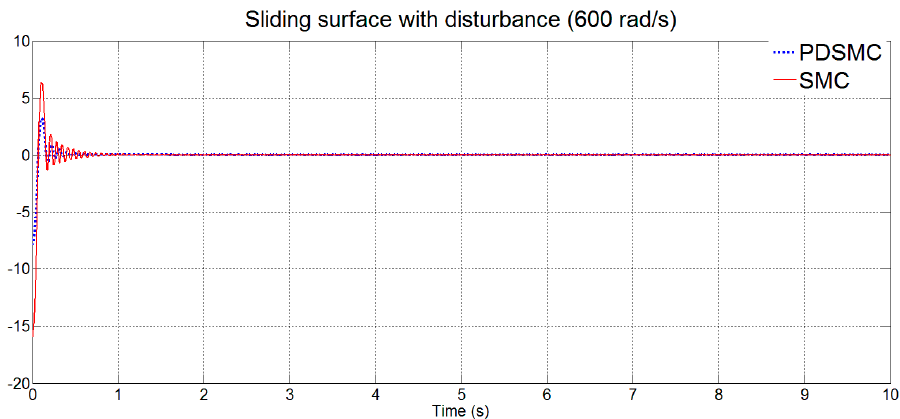
Figure 11. Effect of disturbance on sliding surface.